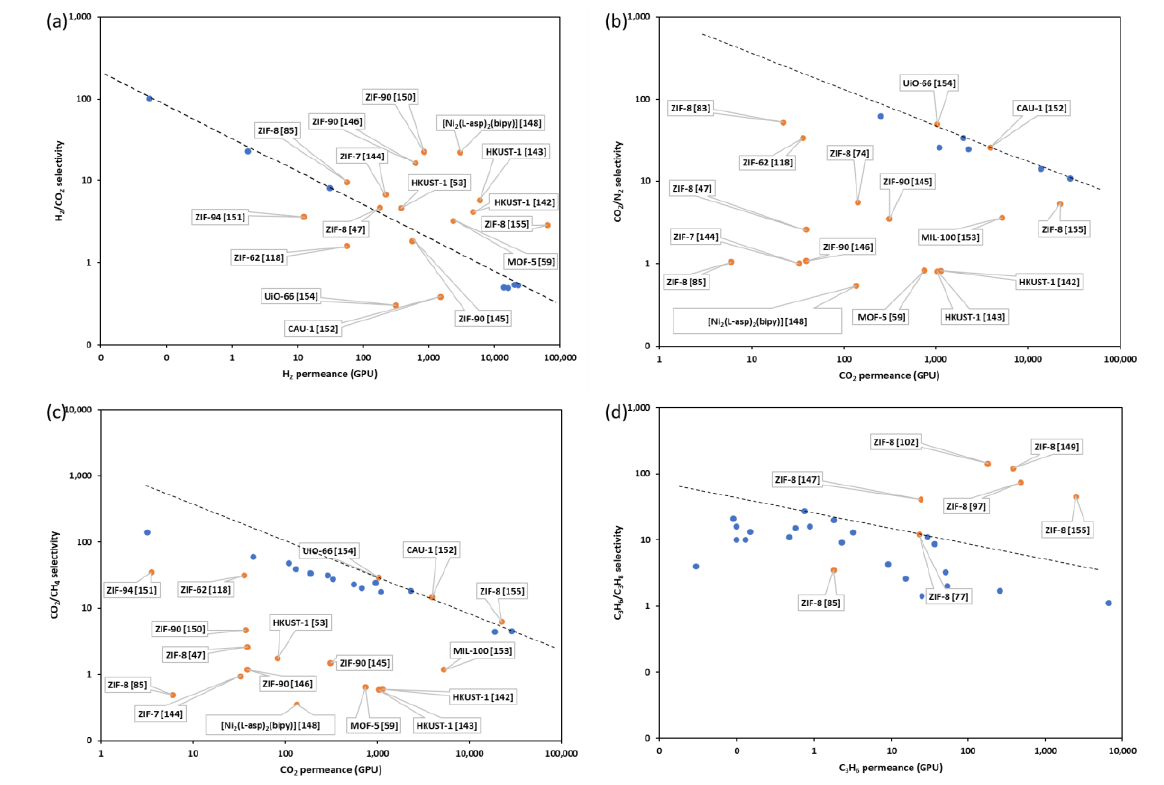
Figure 7. Selectivity-permeance comparisons against upper bounds [156,157]: ( a ) H 2 /CO 2 separation, ( b ) CO 2 /N 2 separation, ( c ) CO 2 /CH 4 separation and ( d ) C 3 H 6 /C 3 H 8 separation. Continuous MOF membranes have mostly been used to act as molecular sieves to separate smaller molecules (H 2 , CO 2 , and C 3 H 6 ) from larger molecules (CO 2 , N 2 , CH 4 , and C 3 H 6 ). Excellent hydrogen permeance and selectivity over the upper bound is witnessed in Figure 7a because the electron-poor H 2 is relatively smaller over CO 2 molecules. However, the performance of the CO 2 separation from N 2 and CH 4 using a continuous MOF membrane is below or close to the upper bound, though there is a large difference between the kinetic diameters of CO 2 and N 2 or CH 4 . Apart from the technical factors